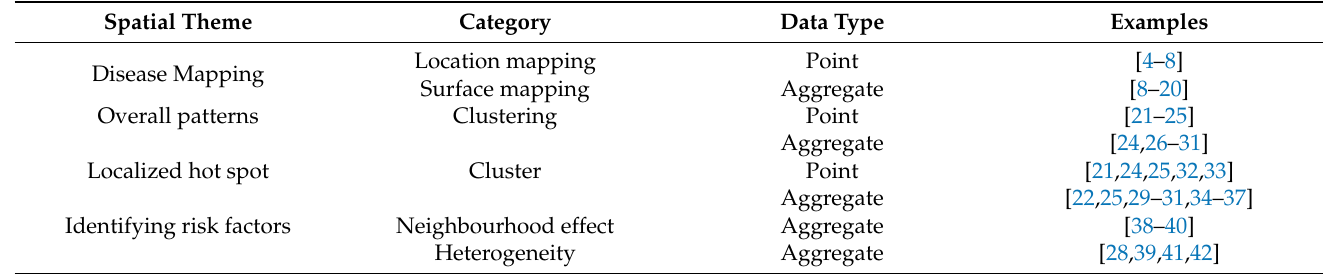
Figure 1. Four main sections in order in this review. Table 1. Summary of themes, categories, data types, and examples in this article.